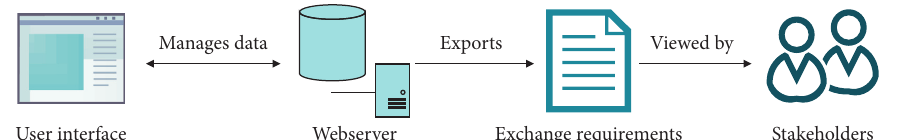
Figure 15: Overview of system design.